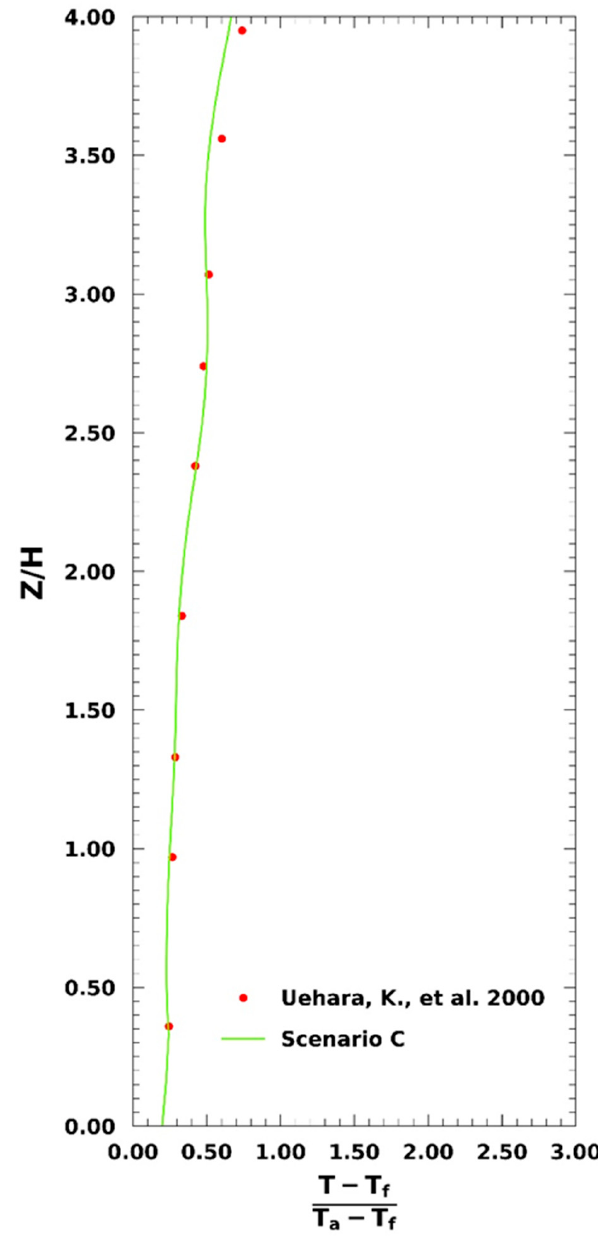
Figure 11. Normalized temperature profiles at the wake region of the flow for Scenario C, at X = 7 H and Y = 5.5 H, where T is the mean temperature, T a is the ambient temperature, and T f is the temperature at the floor of the computational domain.